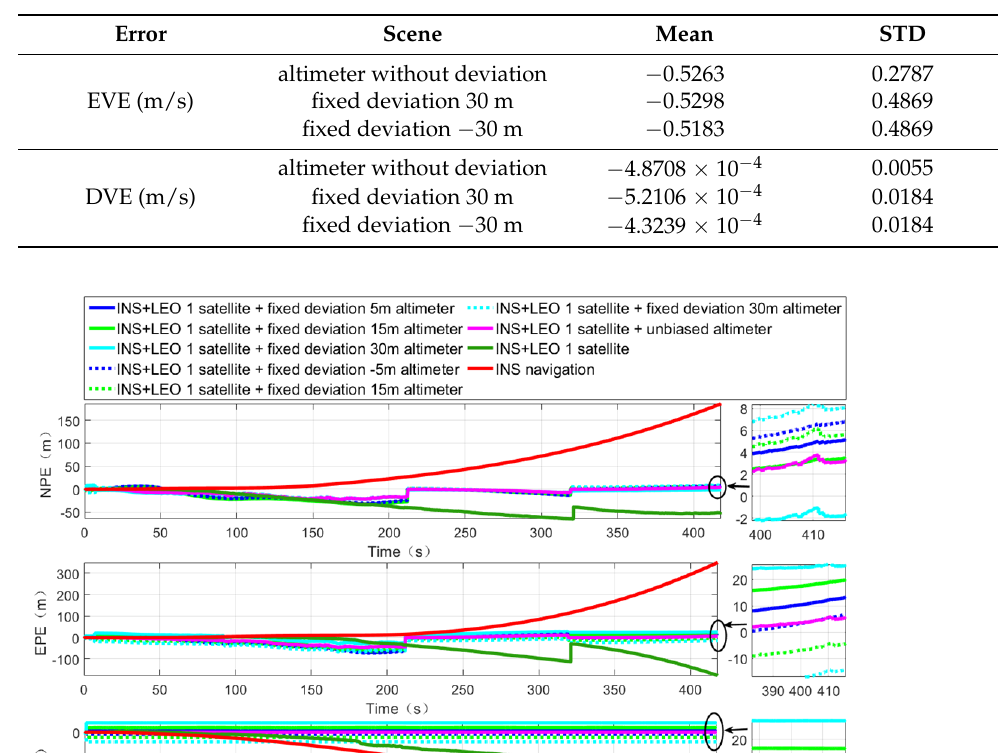
21 of 30 Table 4. Trajectory error statistics.